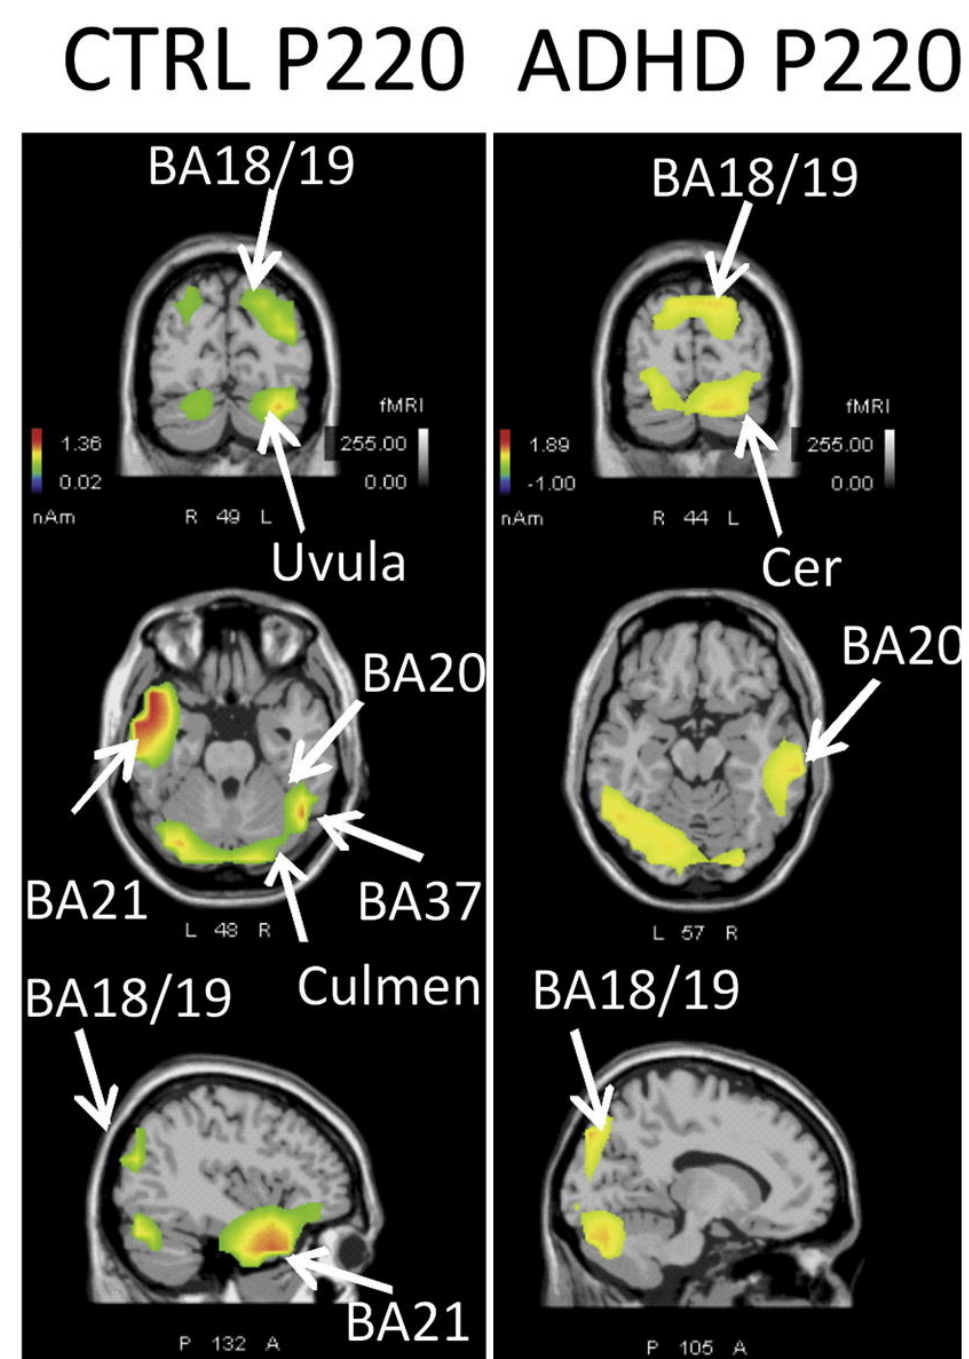
Figure 1. An extract of the results adapted with permission from Ref. [64], © 2018 IBRO. The two image columns show current density distributions within the brain, which have been captured by swLORETA during an ERP